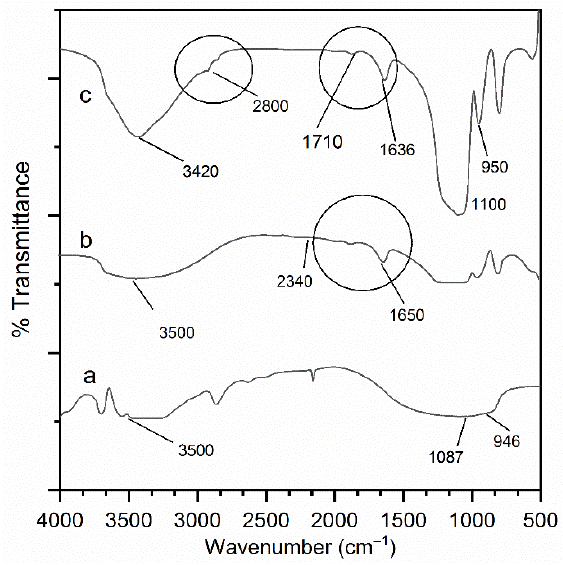
Figure 8. Comparative FT-IR spectra of the ( a ) SiO 2 ( b ) APTES@SiO 2 and ( c ) (3) @APTES@SiO 2.